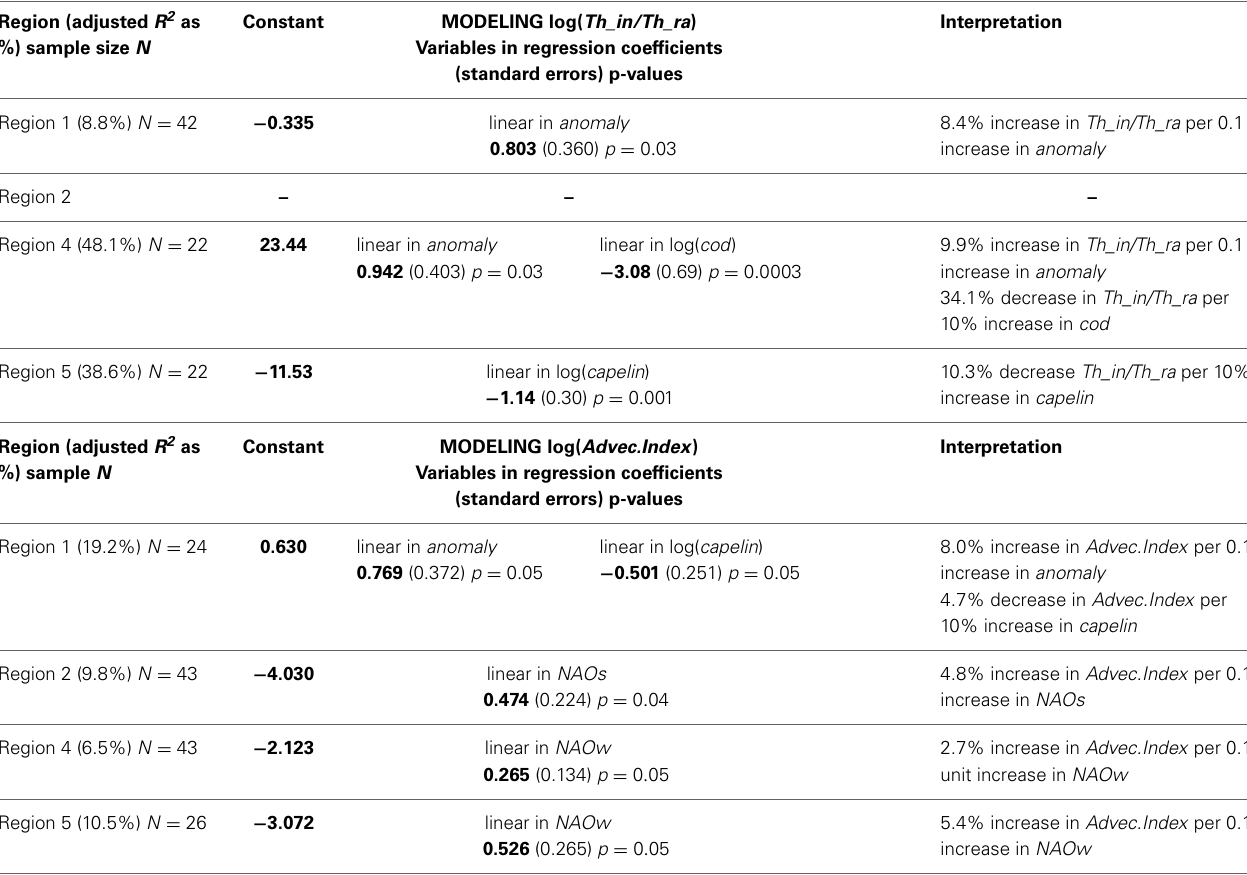
[“Advec. Index” = (M. norvegica + Th. longicaudata)/(total euphausiids)]. The left column contains total sample size (number of years) and the adjusted R 2 of the model. Constants and coefficients along with p-values are presented in the third column. Numerical interpretation is included in the right column. No significant regression was found for the log of T. inermis/T. raschii in Region 2. “anomaly” = Kola Transect temperature anomaly; “NAOs” and “NAOw” = North Atlantic Oscillation Index summer and winter values,